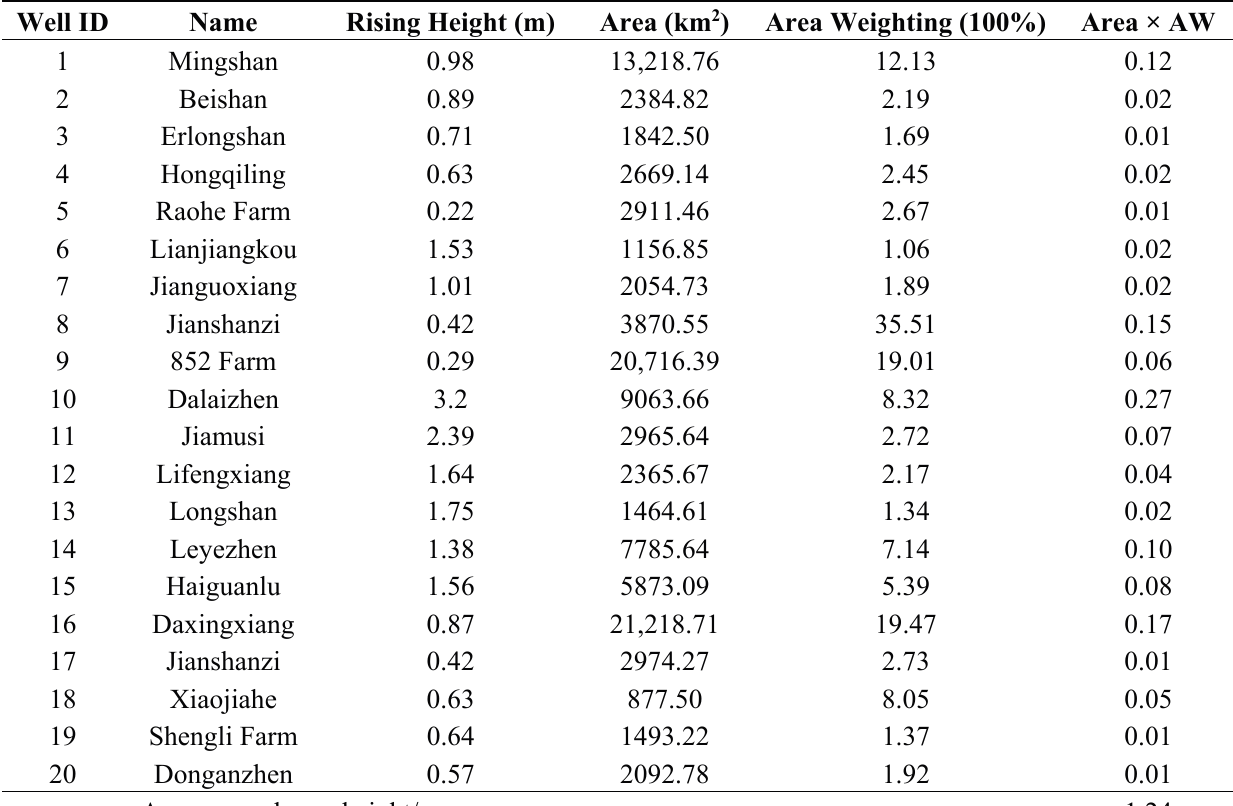
Table 2. Rising height in 20 monitoring wells and their areal presentation in the Sanjiang Plain, Northeast China, following the 2013 summer